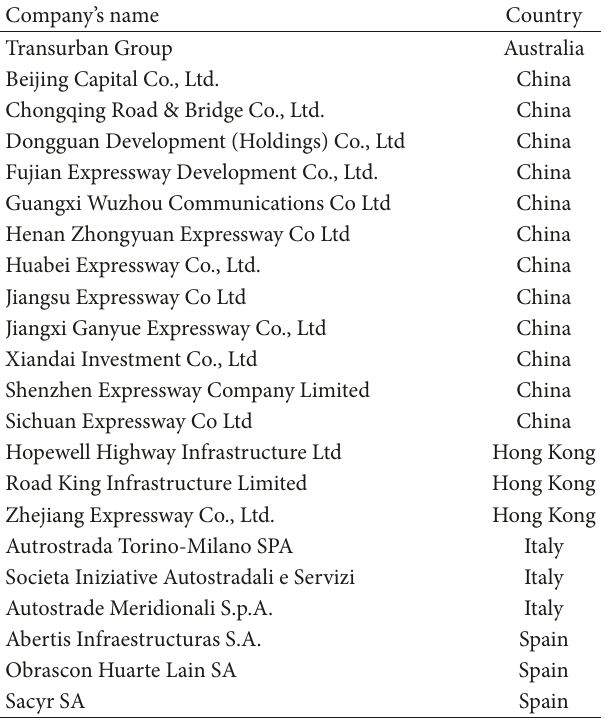
Table 1: Representative offshore concessionaire